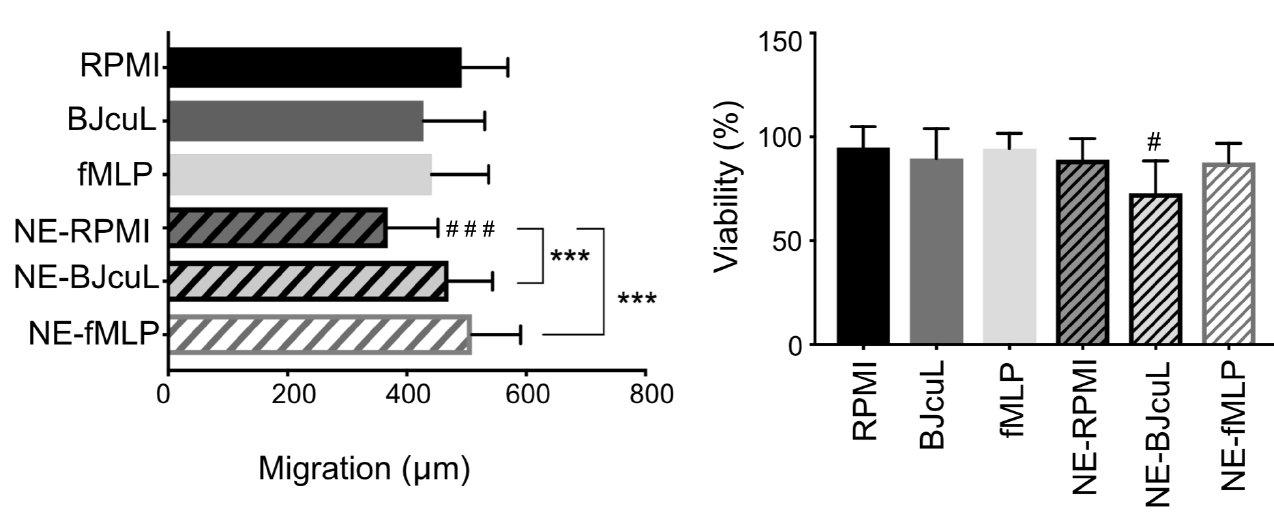
Figure 3. Analysis of migration and viability of SK-N-SH co-cultured with neutrophils. SK-N-SH cells (1 x 10 6 cells/mL) were incubated with RPMI, 2.5 µg/mL BJcuL or 10 µM fMLP alone or in co-culture with human neutrophils (NE; 2.5 x 10 5 cells/mL) for 24 h in a 24-well plate (300 µL/well). Results represent mean ± SD of the migration distance, determined as T0-T48 (n = 12). Viability results are represented as mean ± SD (n = 10) of viable cells normalized to the untreated control (RPMI). Data were obtained from at least three independent assays. Statistical analysis was performed by one-way ANOVA and Tukey’s test with significance shown as *p < 0.05 and ***p < 0.001. # indicates difference comparing with RPMI control.